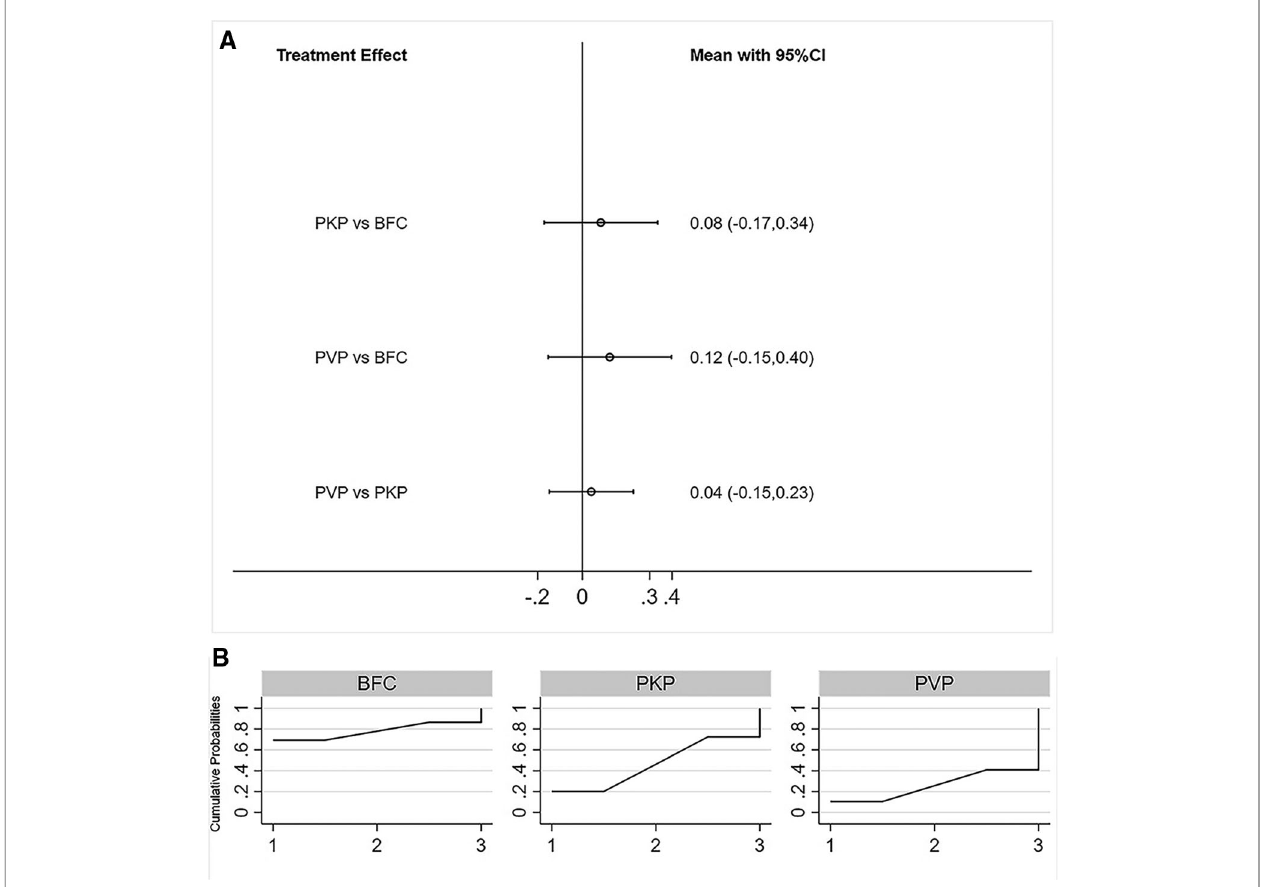
FIGURE 3 | Forest plot of ODI score ( A ) and relevant SUCRA of each procedure ( B ). PVP, percutaneous vertebroplasty; PKP, Percutaneous kyphoplasty; BFC, bone- fi lling mesh